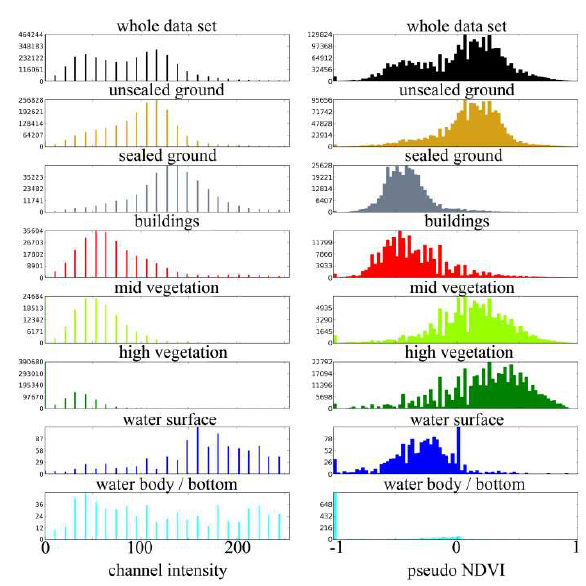
Figure 3. Class specific 8 bit scaled channel histograms for 532 nm wavelength laser signals and pseudo NDVI (counts/bin) Combining all three channel intensities for a pattern matching classification (Fig. 7) leads to a good agreement with the visual inspection obtained from the false colour coded point cloud.